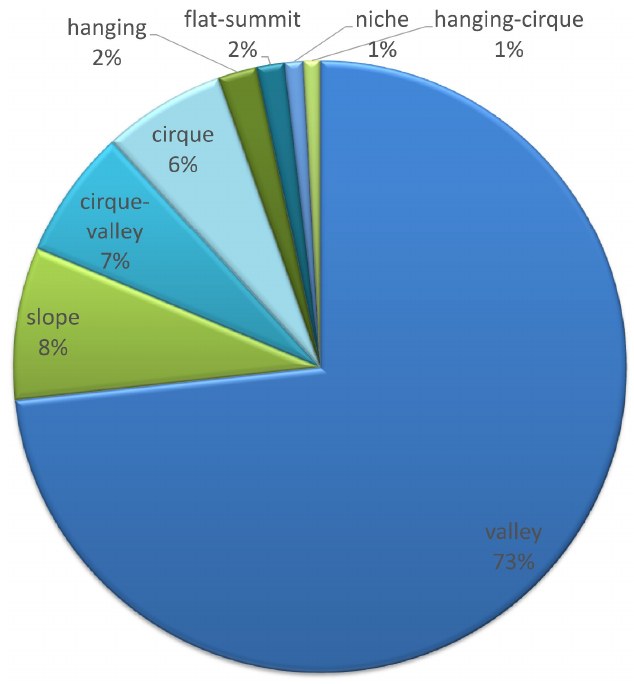
Figure 6. Distribution of glacial area in 2010 by morphological types.